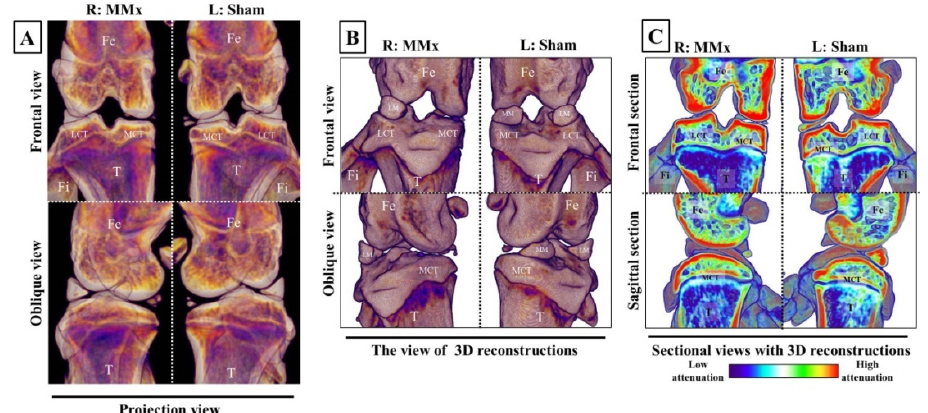
Figure 3. Images of subchondral bones in the knee complex on X-ray µ CT analyses. The pictures show representative examples of projection ( A ), 3D ( B ), and sectional ( C ) views on X-ray µ CT analyses. No changes in the subchondral bones of MMx-treated knees compared with that of sham-treated knees were noted. Abbreviations; Fe, femur; LCT, lateral condyle of tibia; MCT, medial condyle of tibia; T, tibia; Fi, fibula; LM, lateral meniscus; MM, medial meniscus.